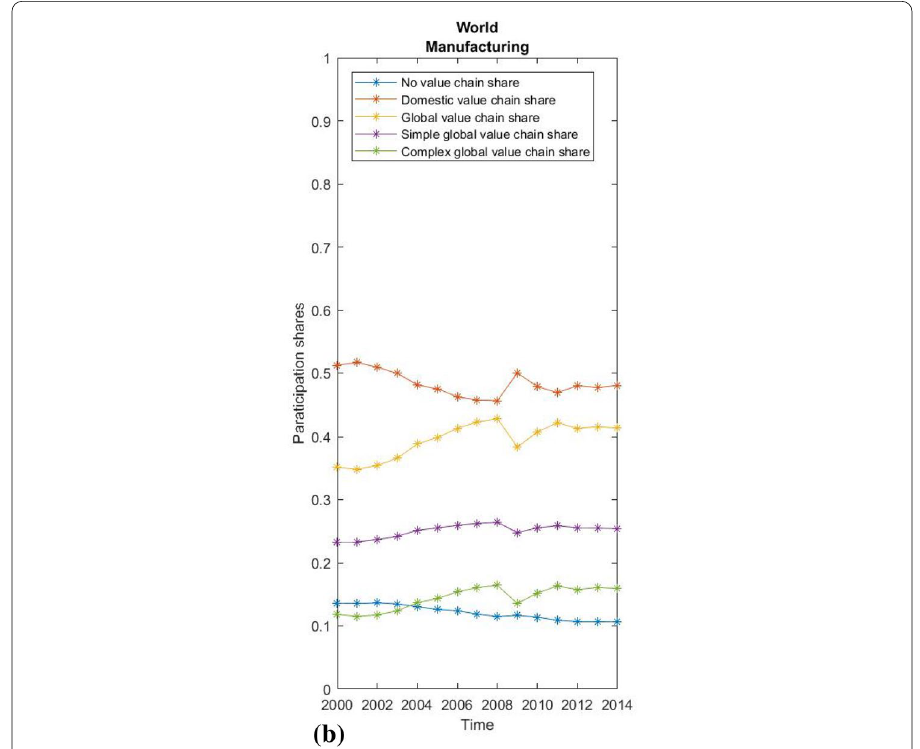
Fig. 3 World average of manufacturing. Source: WIOD, 2016; own